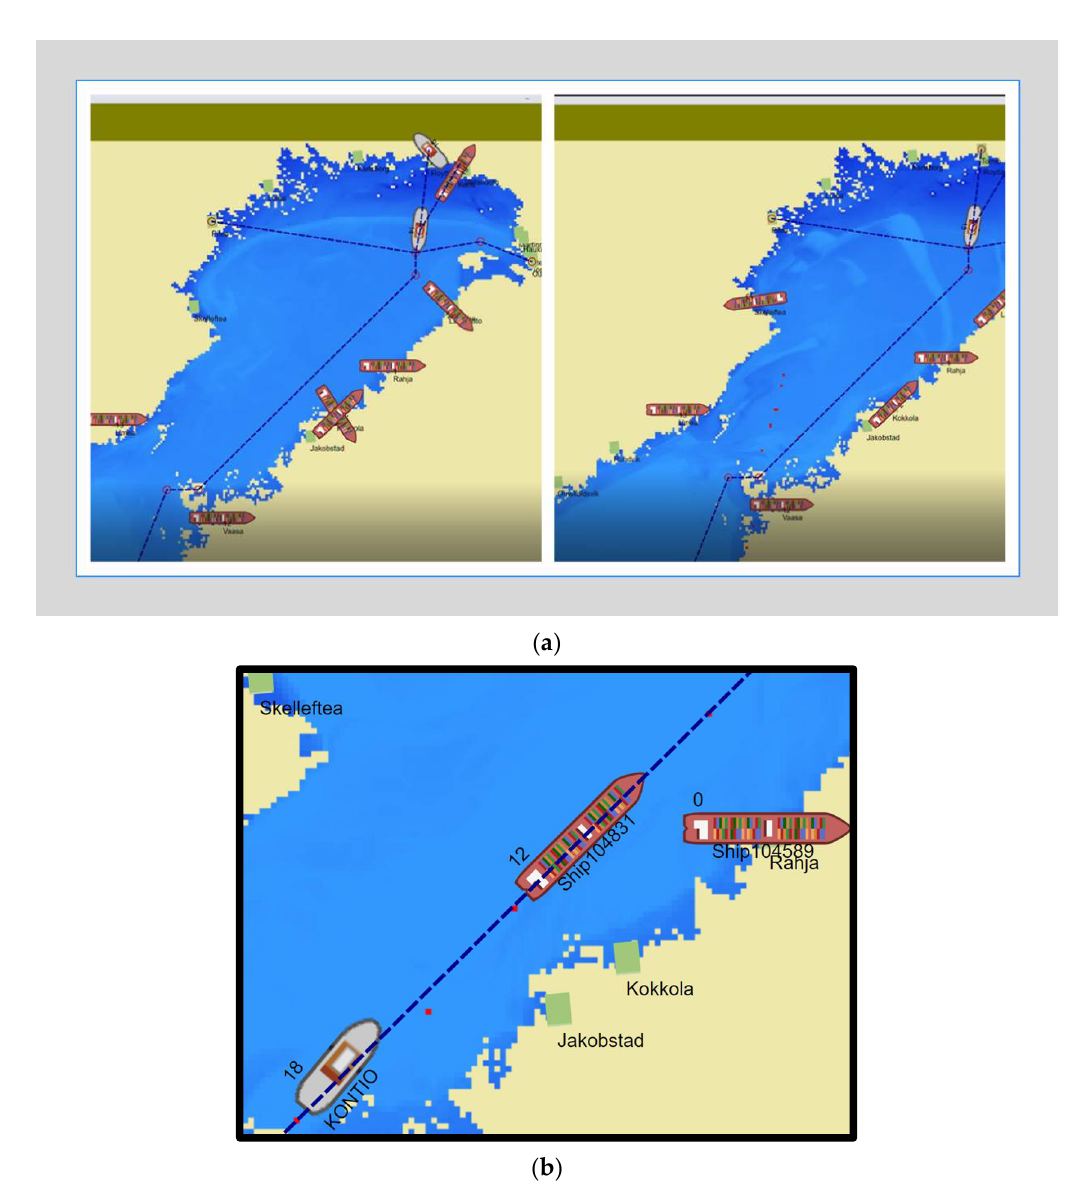
Figure 7. ( a ) Visualization of ice fields and dirways. ( b ) Vessel names and speeds. The validation of the model is described below.